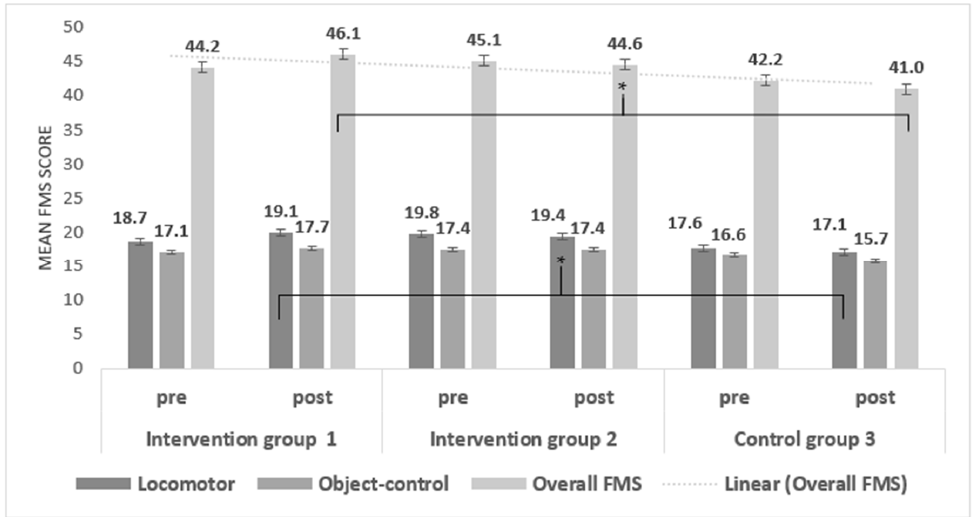
Figure 2. Mean locomotor, object-control, and overall FMS proficiency di ff erences among groups over time (pre to post stages; n = 120). * Significant di ff erence for overall FMS proficiency between group 1 and group 3 ( p ≤ 0.005). Significant locomotor di ff erences between group 1 and 3 ( p ≤